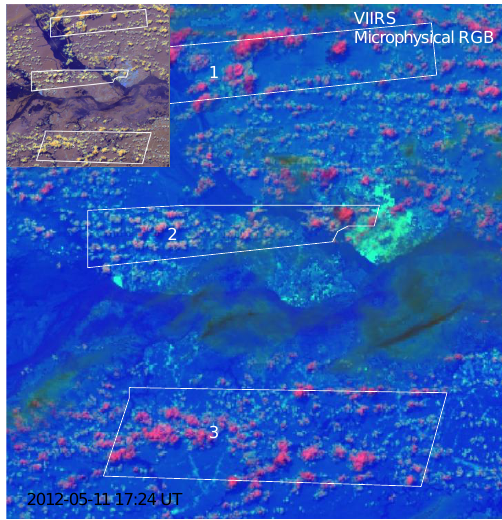
Fig. 16. Imagery of VIIRS overpass on 11 May 2012 17:24UT over Manaus in the Amazon rainforest for an area of 146km × 133km centered at 3.19 ◦ S, 60.29 ◦ W. The color scheme is microphysical RGB. The inset in the upper left is the same area in solar RGB that better shows the surface features and the Amazon River. The city of Manaus can be seen as the bright blue area at the right edge of area 2, which marks the plume of polluted clouds, which move from east to west (right to left). The pristine background clouds are shown in areas 1 and